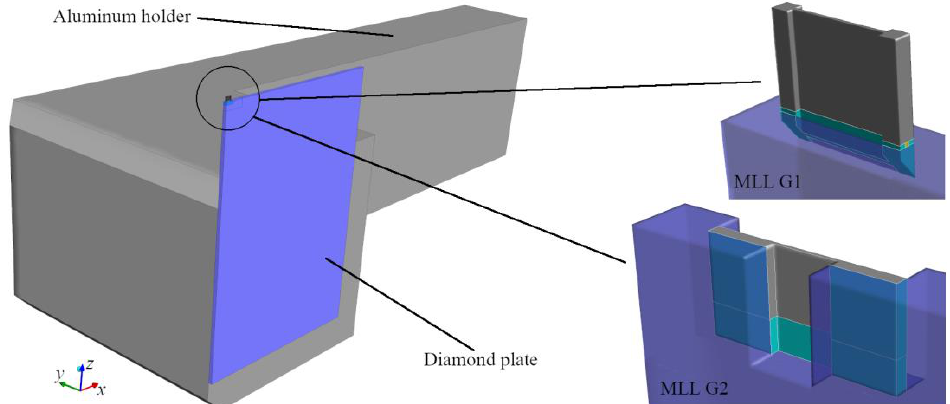
Figure 3. Geometric model, indicating MLL connected to a diamond plate that is attached to a larger aluminum holder. The MLL was cut from a multilayer deposited on a Si substrate (turquoise). The coordinate system is indicated with the X-ray beam parallel to the y coordinate.